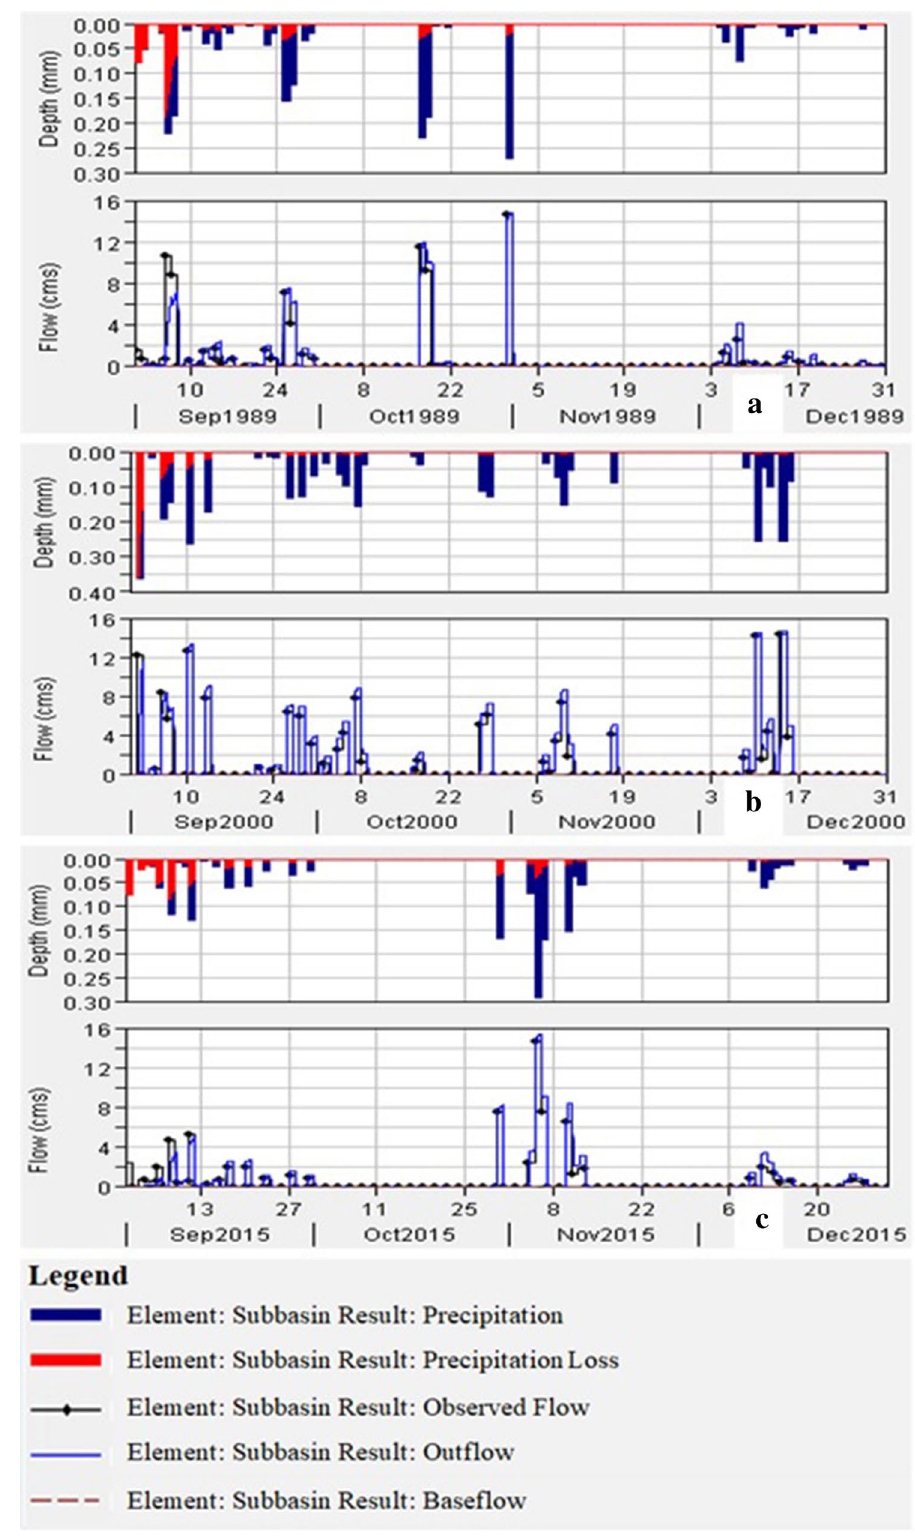
Fig. 7 Validation of HEC-HMS model (01 Sep to 31 Dec) ( a ) 1989 ( b ) 2000 ( c )